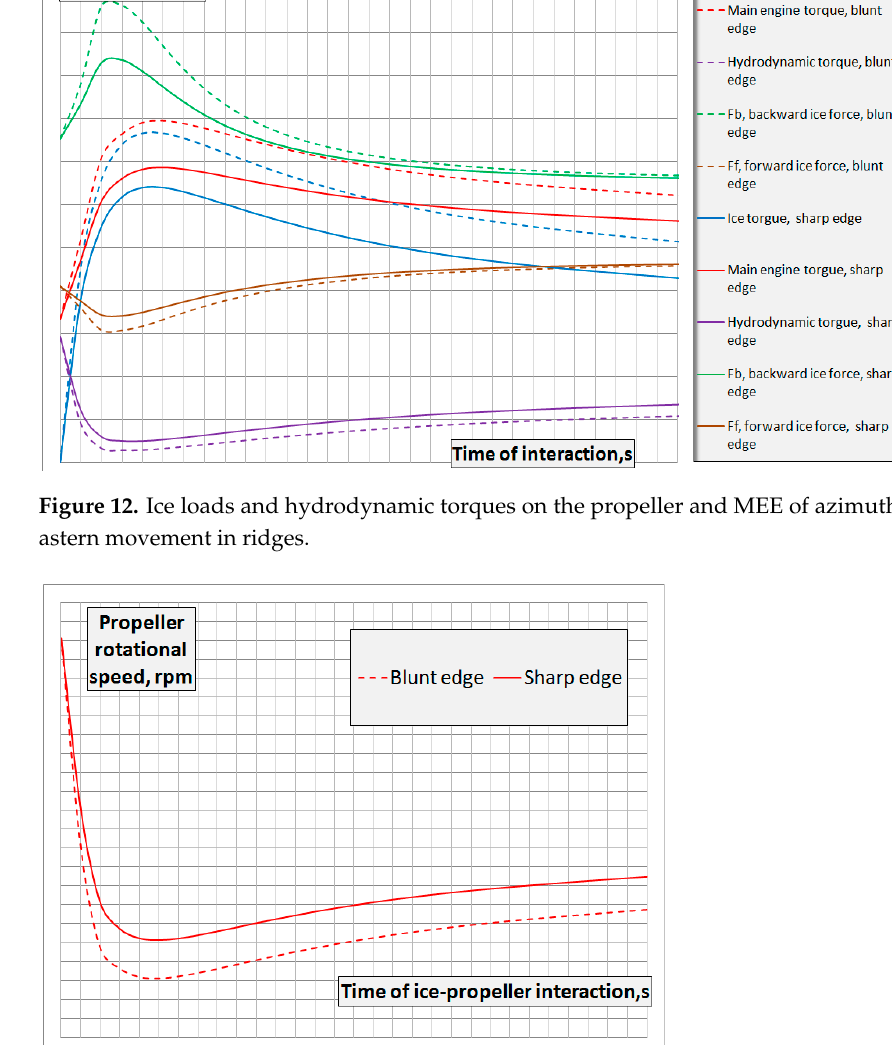
Figure 13. Propeller speed dropping during movement astern in ridges.